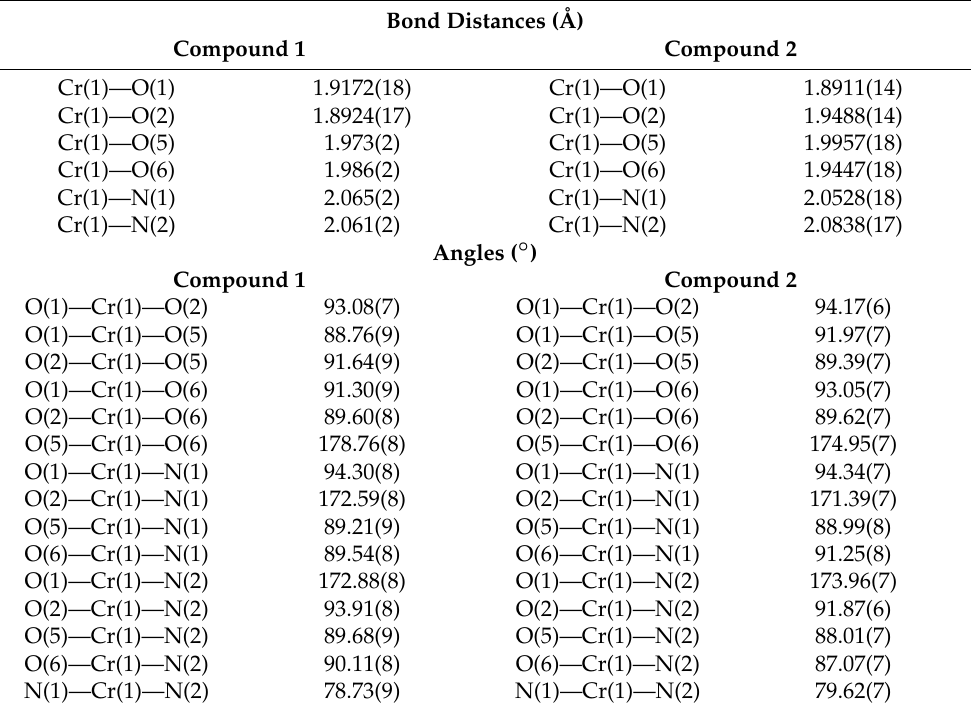
Table 1. Selected geometric parameters (Å, ◦ ) in the structures of [Cr(C 15 H 9 O 4 )(C 10 H 8 N 2 ) (H 2 O) 2 ]